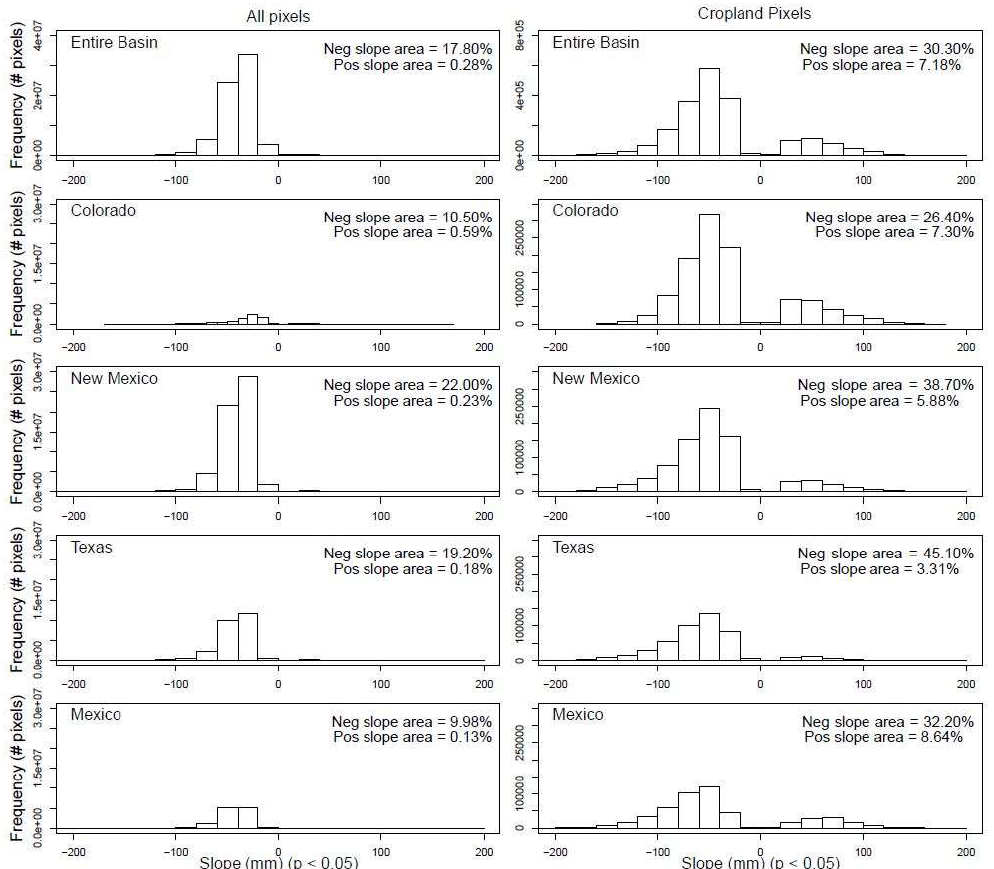
Figure 11. Histogram plots showing frequency distribution of pixels with significant negative (neg) or positive (pos) slope ( p < 0.05) for ETa over the entire basin or regions. Left panel shows all pixels (all land cover types) and right panel is only for cropland areas. Note that the percentages do not add up to 100% as the neutral (non-significant changes) areas are not shown.